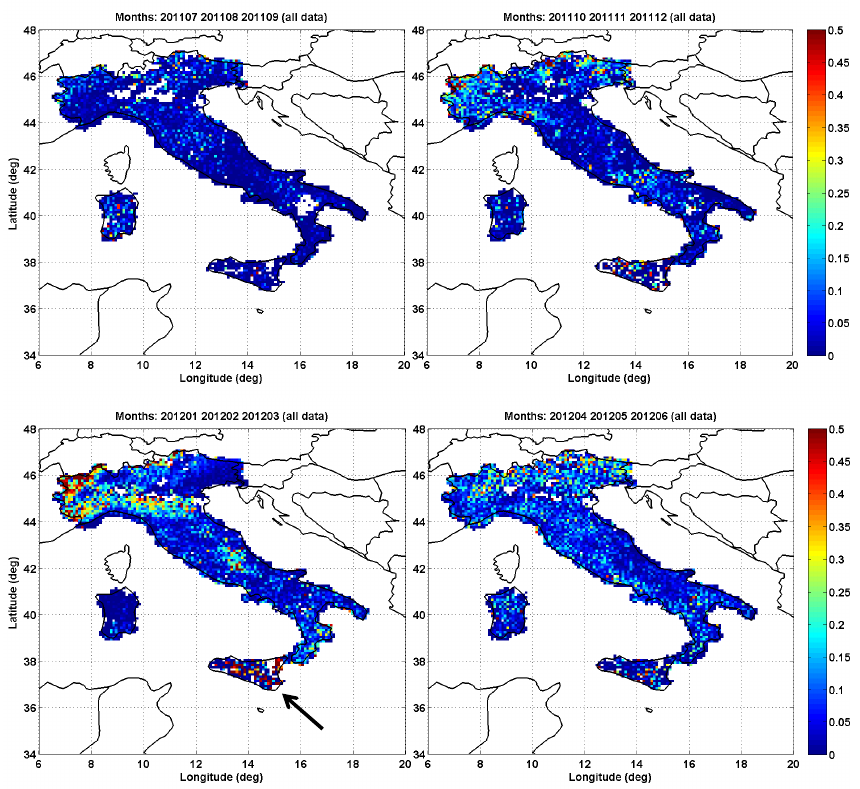
Figure 10: Maps of seasonal mean absolute difference with respect to RGN; clockwise from top-left 3 Fig. 10. Maps of seasonal mean absolute difference with respect to RGN. Clockwise from top-left panel: summer (July-August-September 2011), fall (October-November-December 2011), winter (January-February-March 2012), and spring (April-May-June 2012). The vertical panel: Summer (July-August-September 2011), Fall (October-November-December 2011), Winter 4 color bar is in mmh − 1 . The black arrow in the lower-left panel indicates (January-February-March 2012), and Spring (April-May-June 2012). The vertical color bar is in 5 mm/h. The black arrow in the lower-left panel indicates Sicily. 6